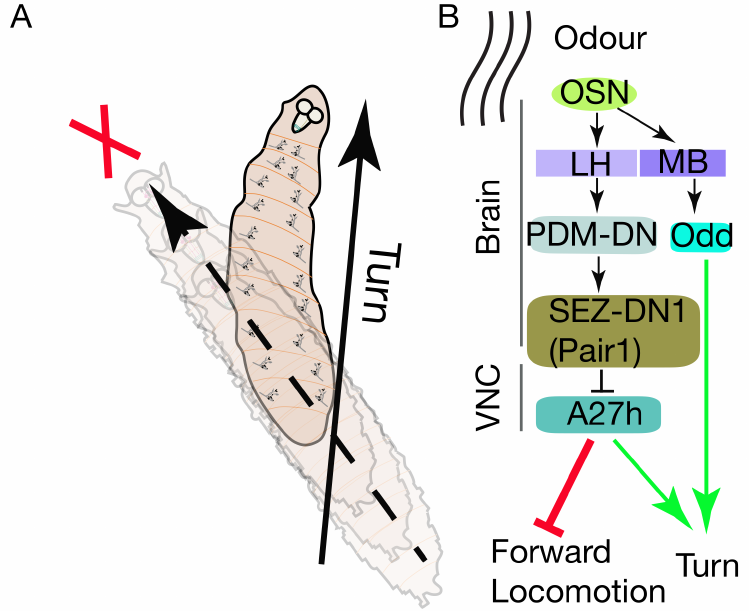
Figure 7. Neural circuit involved in chemotaxis. ( A ) Schematic depicting larval turning towards attractive food odor. ( B ) Neural circuits showing chemotactic pathways involving either MB or LH leading to inhibition of forward locomotion and promoting turn towards odor (adapted and modified from